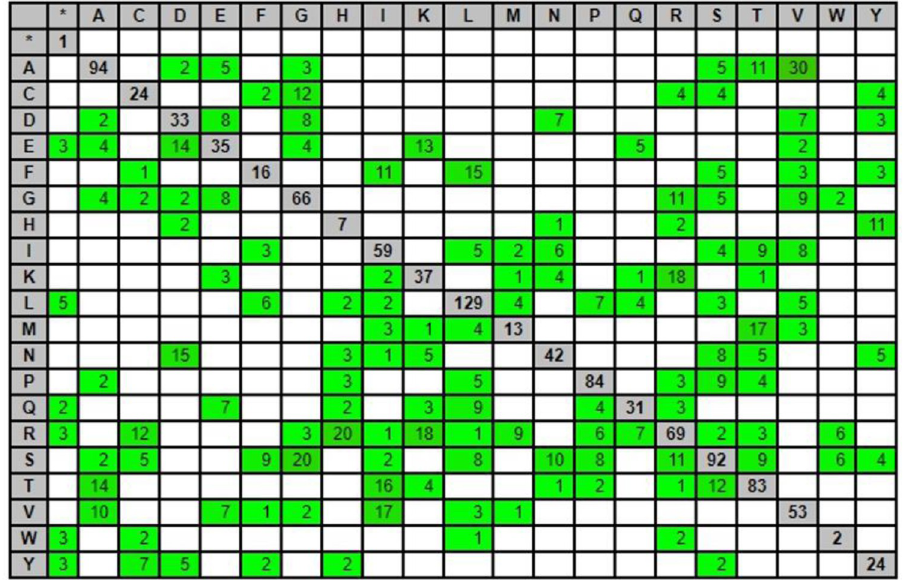
Fig 2. Amino acid changes of the variants in SnpEff analysis of the GBS derived SNPs. (Rows are reference amino acids and columns are changed amino acids. For example: 2 Alanine have been replaced by Aspartic acid. The increase in intensity of green colour indicate the increase in number of amino acid changes and the diagonals are indicated in grey background colour). The amino acid codes- A: Alanine; C: Cysteine; D: Aspartic acid; E: Glutamic acid; F: Phenylalanine; G: Glycine; H: Histidine; I: Isoleucine; K: Lysine; L: Leucine; M: Methionine; N: Asparagine; P: Proline; Q: Glutamine; R: Arginine; S: Serine; T: Threonine; V: Valine; W: Tryptophan; Y: Tyrosine.